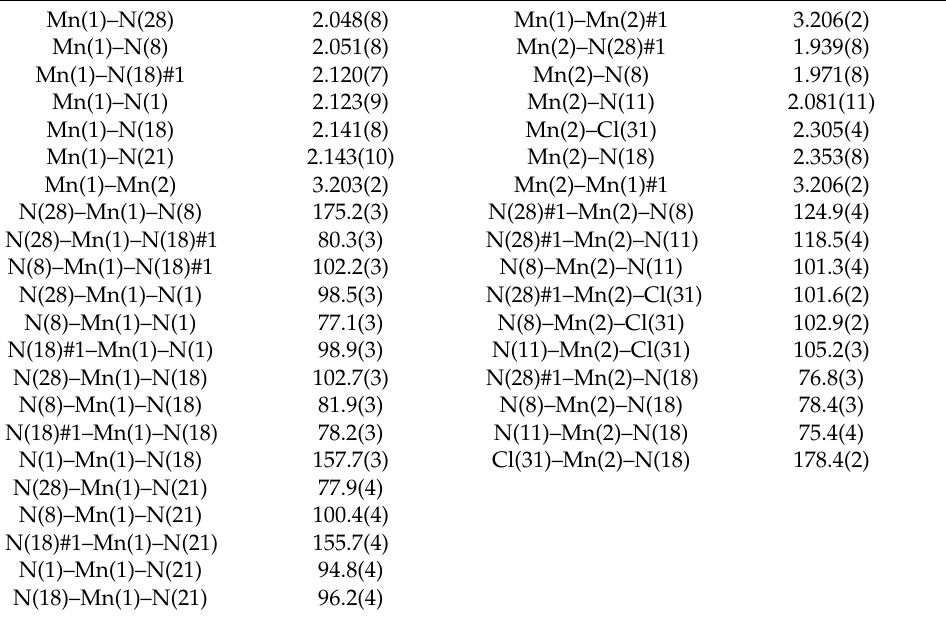
Table 3. Selected bond lengths (Å) and angles (°) for 2